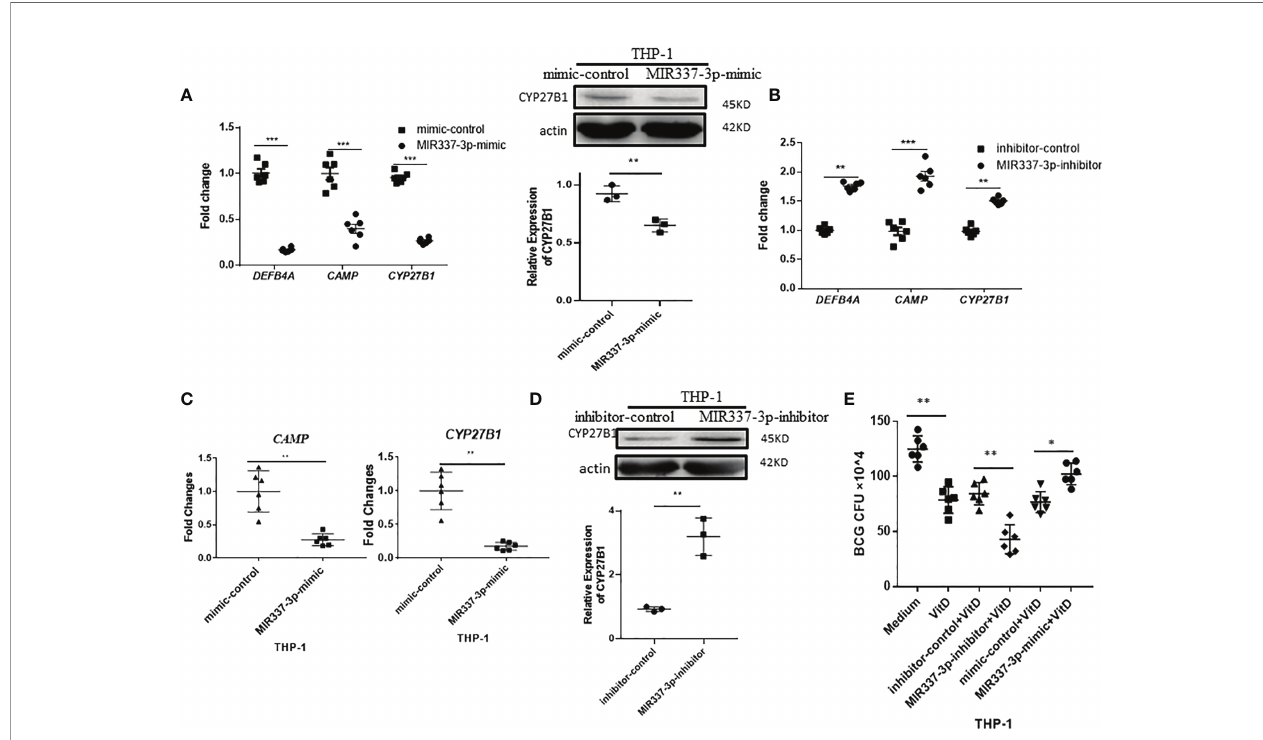
FIGURE 4 | MIR337-3p depressed antimicrobial response of VDR-related CYP27B1, DEFB4A, and CAMP pathways. (A) Transfection of MIR337-3p mimics downregulated gene expression of DEFB4A , CAMP , and CYP27B1 in THP-1 cells at 24 h after transfection, respectively (left panel). And transfection of MIR337-3p mimics depressed CYP27B1 protein expression in THP-1 cells (right panel). (B) The gene expressions of DEFB4A , CAMP , and CYP27B1 were higher in MIR337-3p inhibitor-transfected THP-1 cells than those in inhibitor-control-transfected cells, respectively. (C) shows relative gene expression levels of CAMP and CYP27B1 in MIR337-3p mimic- and control-transfected cells in stimulation of vitamin 1,25-(OH)2D3, respectively. (D) shows representative results in Western blot (WB) indicating that MIR337-3p inhibitor enhances CYP27B1 protein expression in THP-1 cells in stimulation of vitamin 1,25-(OH)2D3. (E) shows BCG CFU counts in vitamin 1,25- (OH)2D3-treated THP-1 cells, which were transfected with MIR337-3p mimics or inhibitors and their controls, respectively. Data are represented as mean ± standard errors. *P<0.05, **P < 0.01 and ***P <